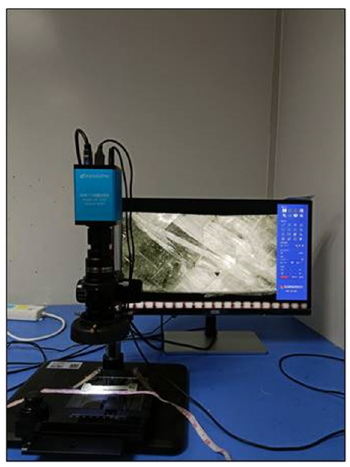
Figure 6: Characterization by high - de fi nition CCD optical microscopy.